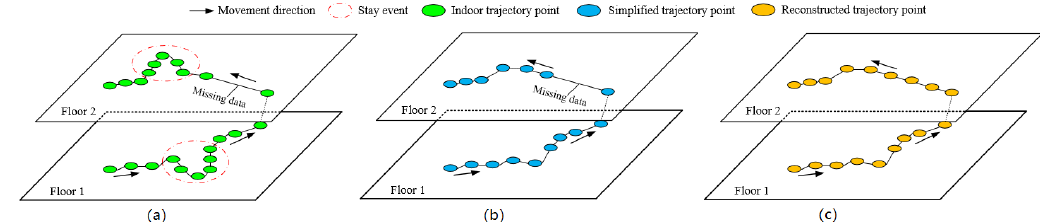
Figure 1. Basic definition: ( a ) raw trajectory of a user; ( b ) simplified trajectory of a user; and ( c ) reconstructed trajectory of a user.